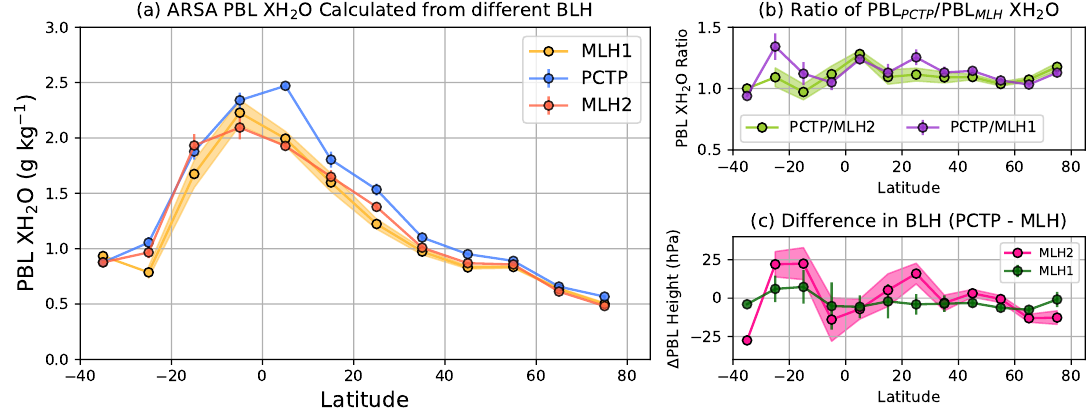
Figure 6. Comparison of mean ARSA PBL XH 2 O calculated using the mixing layer height (MLH) derived from; (i) the original radiosonde profile (MLH1), (ii) the partial column top pressure (PCTP) and (iii) MLH derived from the radiosonde profile on the GOSAT retrieval grid (MLH2) as a function of latitude are shown in ( a ). The mean ratio of the PBL XH 2 O calculated from the PCTP relative to the MLH as a function of latitude are shown in ( b ). The global mean ratios of PCTP to MLH1 and MLH2 are 1.13 and 1.09 respectively. The mean differences between the PCTP and MLH as a function of latitude are shown in ( c ). All shaded regions and error bars are the respective standard error for each latitudinal bin.